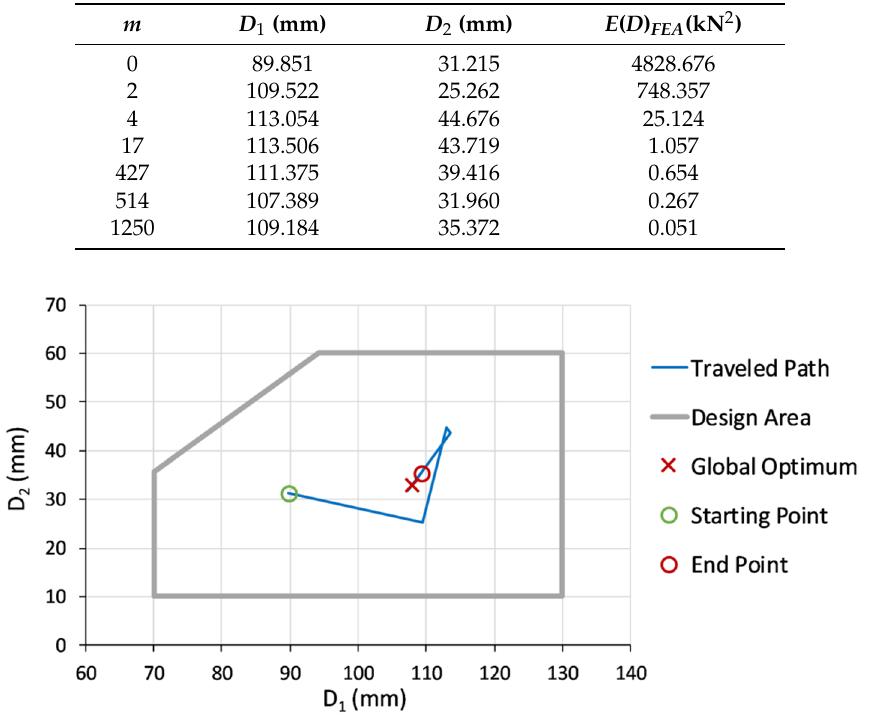
Figure 6. Investigated design points by the local search algorithm.